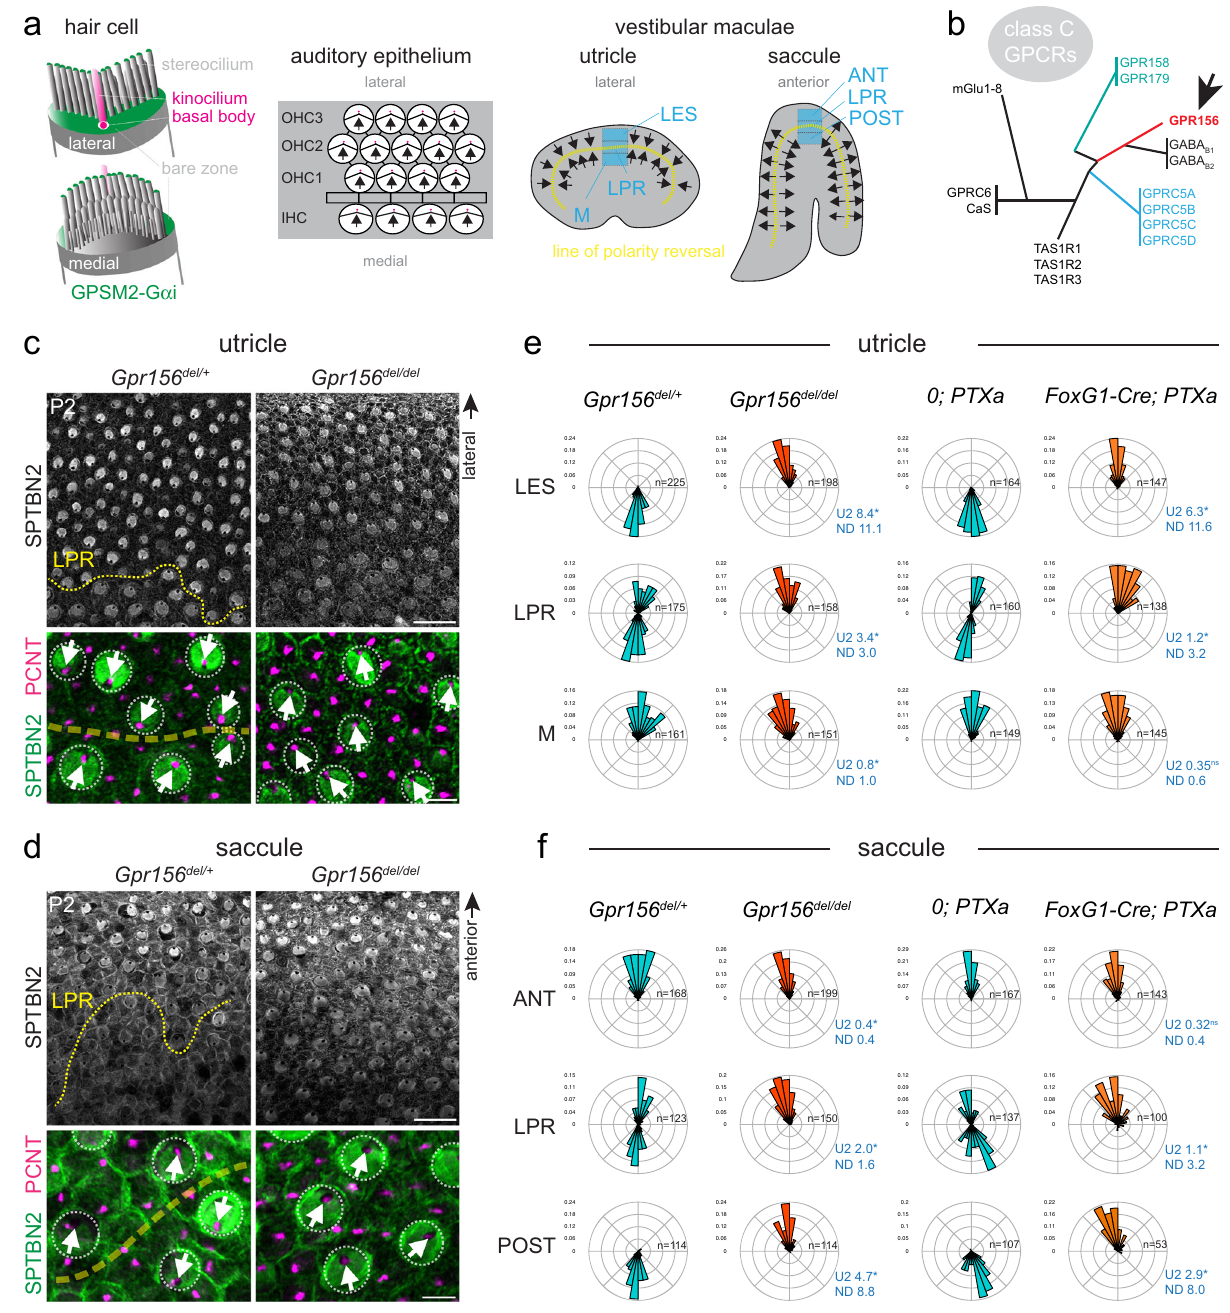
Fig. 1 Gpr156 or G α i inactivation abrogates hair cell reversal in the mouse maculae. a Schemes representing a single auditory HC from the lateral/ abneural (top) or medial/neural (bottom) side, and HC orientation (arrows) in the auditory epithelium and the utricular and saccular maculae. In the maculae, two HC populations of opposing orientations are separated by a virtual line of polarity reversal (LPR, yellow dashed line). Domains where HC orientation was quanti fi ed in e , f are indicated in blue (utricle: lateral extrastriolar (LES), LPR and medial (M) domains; saccule: anterior (ANT), LPR and posterior (POST) domains). b Phylogenetic tree of class C GPCRs adapted from 62 . c , d LPR region in P2 utricle ( c ) and saccule ( d ). Top panels show a low magni fi cation view with SPTBN2 ( β II-spectrin) labeling revealing HC orientation by the position of the off-center fonticulus devoid of signal. Bottom panels show a distinct region at higher magni fi cation where PCNT (Pericentrin) labels the basal body below the fonticulus. The LPR can be traced in controls but not in mutants, where all HCs generally point laterally in the utricle and anteriorly in the saccule. e , f Circular histograms of HC orientation by region in the utricle ( e ) and saccule ( f ). Histograms show frequency distribution at P0-P2 (10° bins in a referential where 90° (top) is lateral in the utricle and anterior in the saccule; n indicates HC number in N = 4 animals; Watson U2 test of homogeneity; normalized difference (ND) value indicates how many standard deviations separate the circular means of each distribution). PTXa indicates the Cre-inducible R26-LSL-PTXa allele. Littermate controls for FoxG1-Cre ; PTXa are Cre-negative PTXa animals. Arrows indicate HC orientation. Scale bars are 20 µ m ( c , d top), 5 µ m ( c , d